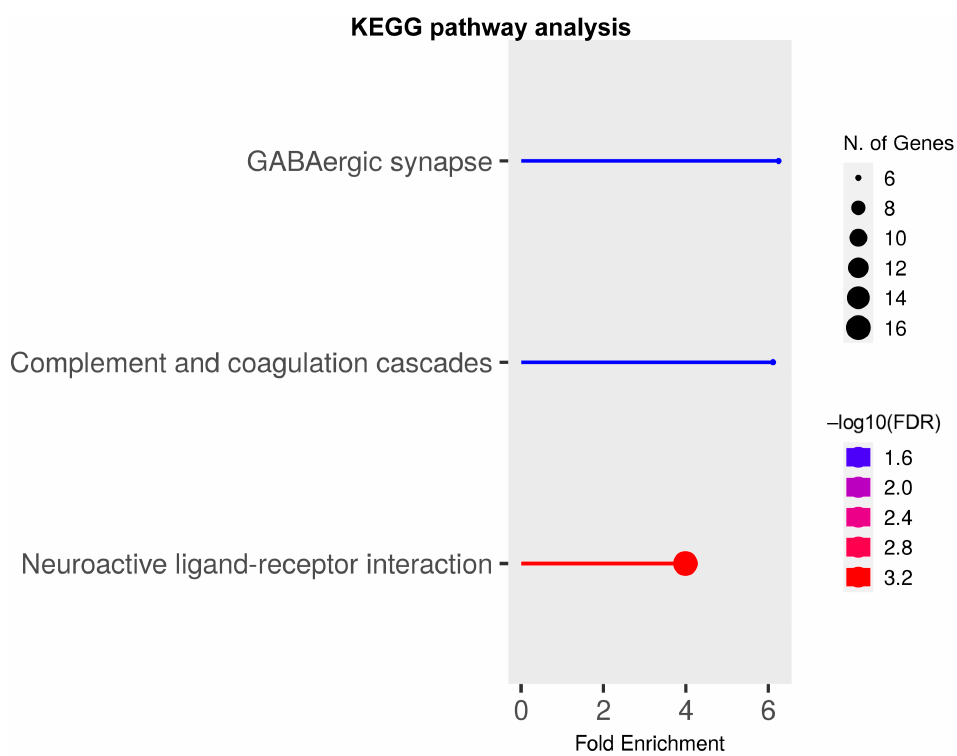
Figure 3. KEGG pathway analysis of DEGs at P17. Functional clusters are enriched for DEGs at P17. Color indicates the value of − log10 (FDR) and circle size indicates the enrichment of gene number.